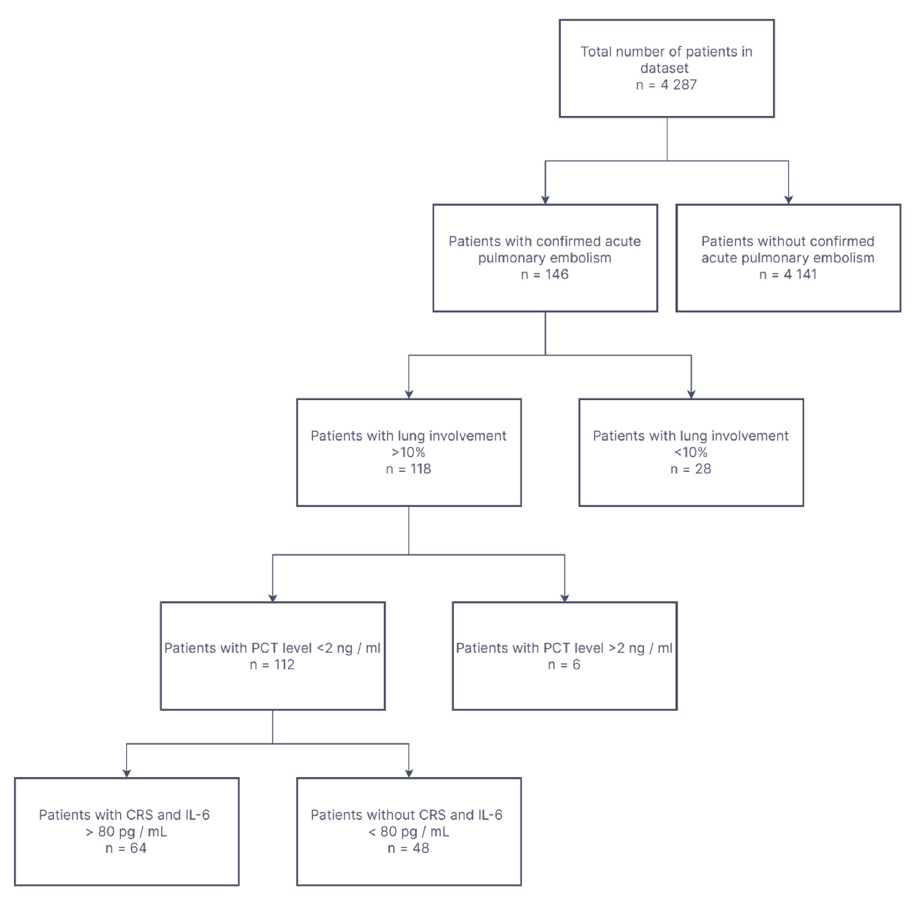
Figure 1. Study flow diagram.